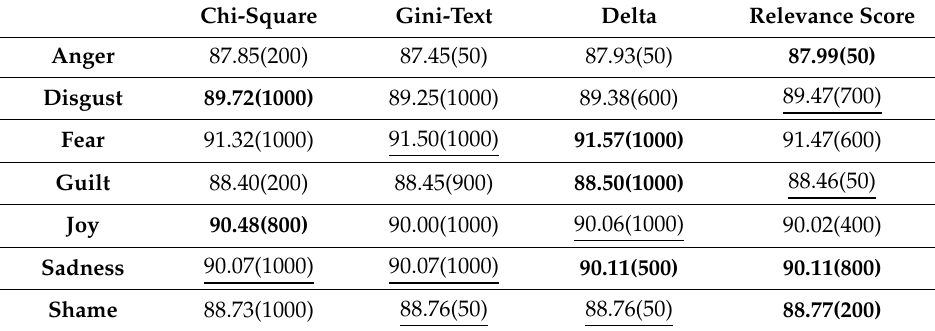
Figure 1. Accuracy results in the International Survey on Emotion Antecedents and Reaction (ISEAR) dataset. ( a ) Anger, ( b ) disgust, ( c ) fear, ( d ) guilt, ( e ) joy, ( f ) sadness, and ( g ) shame. Table 2. Best and second best accuracies and the number of terms used in ISEAR. Chi-Square